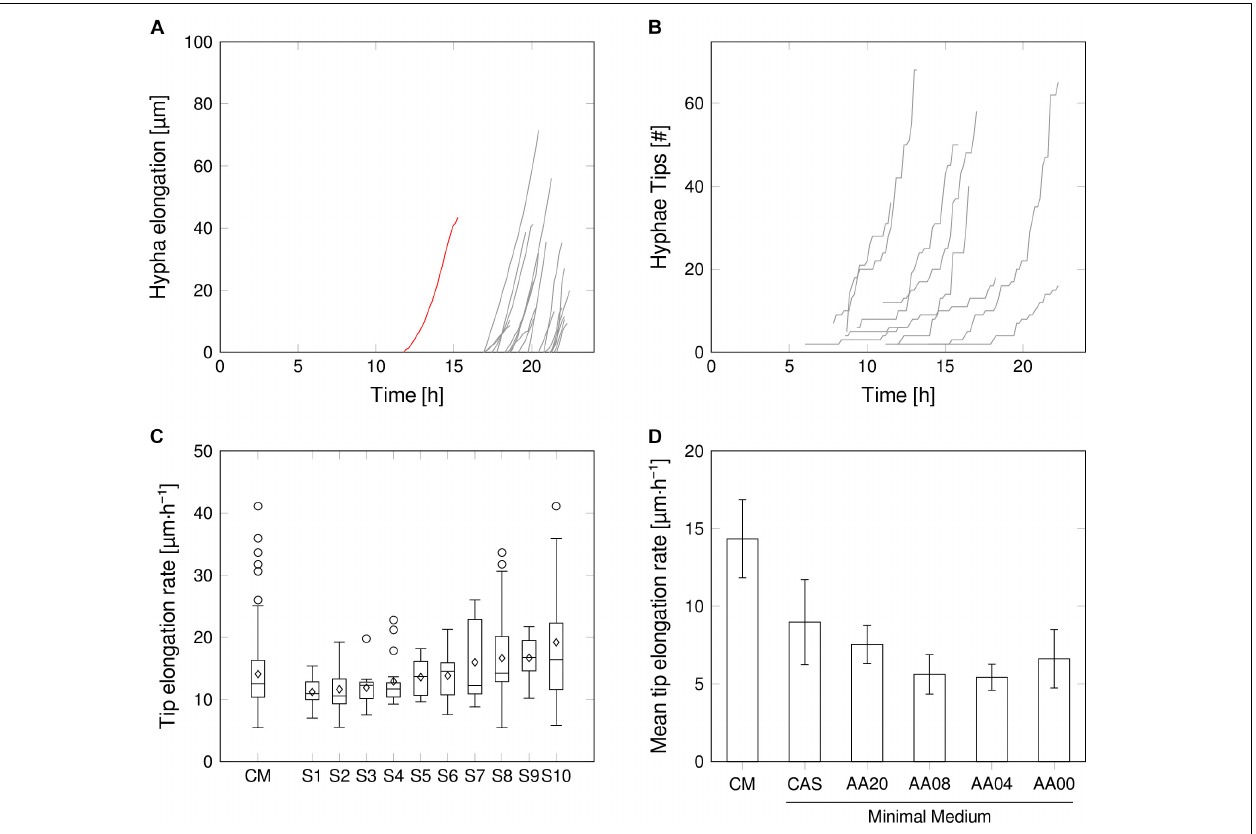
FIGURE 4 | Intrinsic growth heterogeneity on mycelium level. (A) Additional length of the developing mycelium in one representative chamber. Primary hyphae (red) and subsequent hyphae after branching (gray). (B) Number of hyphal tips, exemplarily for several spores in complex medium. (C) Tip elongation rate distribution for all and 10 representative spores supplied with CM. Outliers may be provoked by missing or falsely annotated links between image frames. (D) Average tip elongation rate (average of mean tip elongation rate of all evaluated spores of each medium condition). Detailed tip elongation rates for each medium condition are provided in Supplementary Material S4